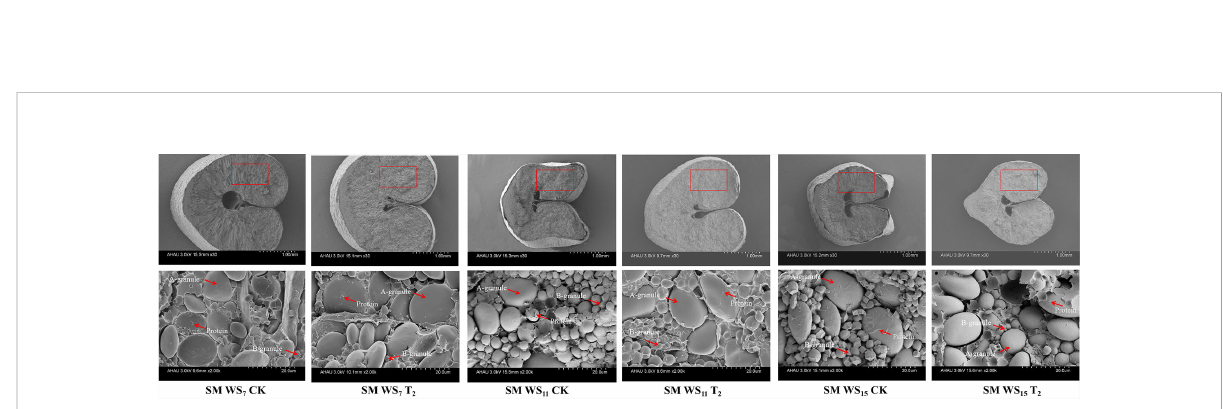
FIGURE 4 The effects of exogenous 6-BA on fi nal starch grain morphology under waterlogging and shading. SM, Sumai 188, 2021. WS 7 , WS 11 , and WS 15 respectively represent treatments under waterlogging and shading for 7, 11, and 15 days after anthesis. Shade nets with a shading rate of about 45% were used for shading, and waterlogging preserves about 2 cm of moisture on the surface of the soil. CK refers to the control sprayed with distilled water; T 2 : the concentration of 6-BA sprayed is 25 mg·L − 1 . The red rectangles in the graphs indicate the range of areas to be